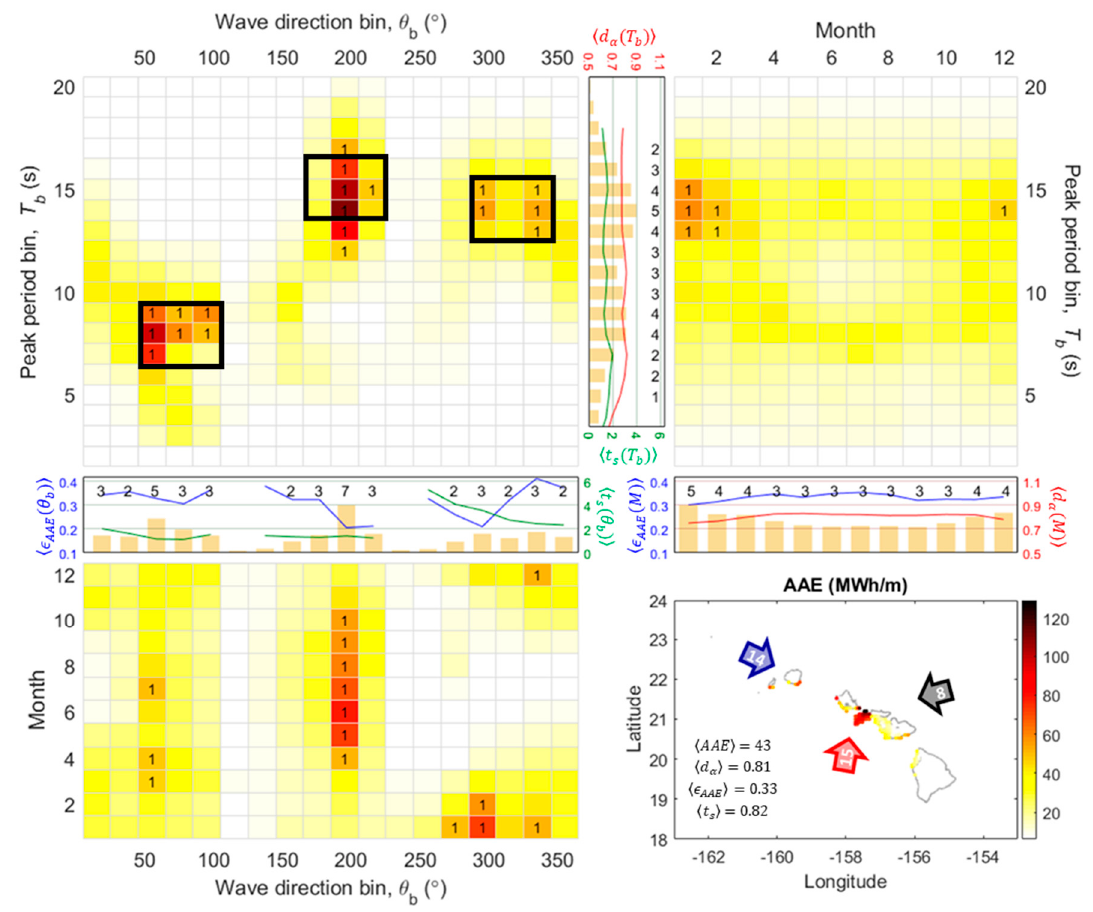
Figure 7. [Region 6: Hawaiian—Southern Coast] The detailed descriptions are identical to Figure 2.